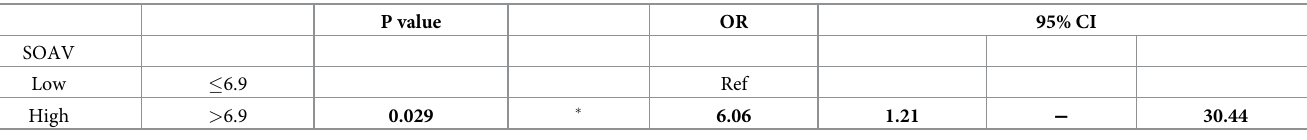
Other covariates (such as temperature, humidity, and age) were adjusted. � p <